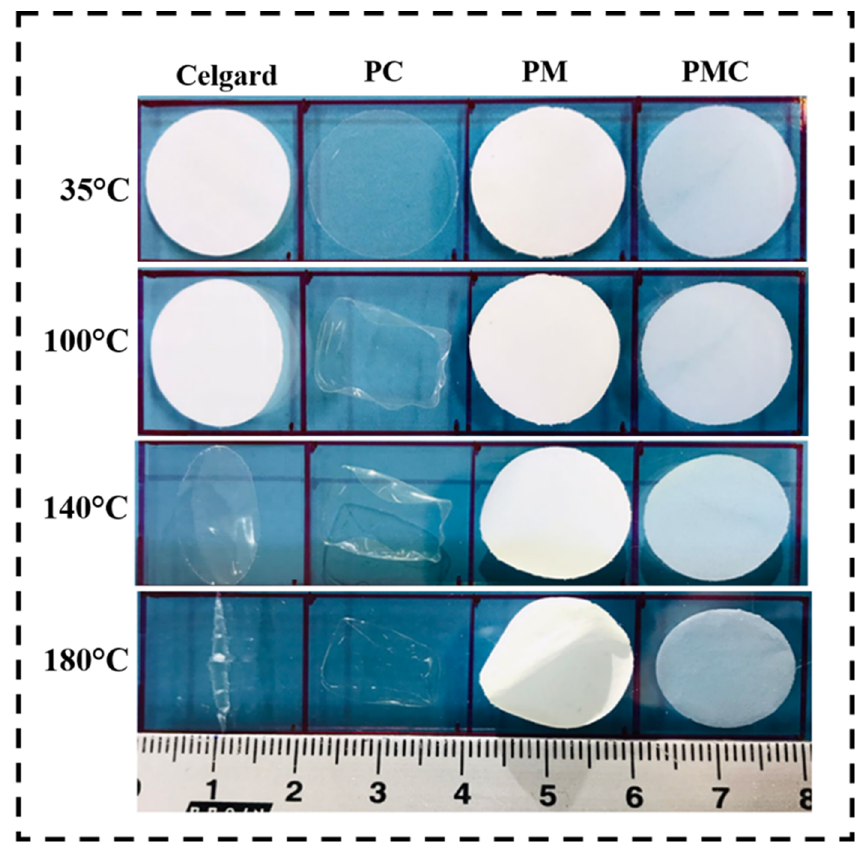
Figure 4. Photographs of polymer membranes subjected to a physical deformation test at various temperatures.